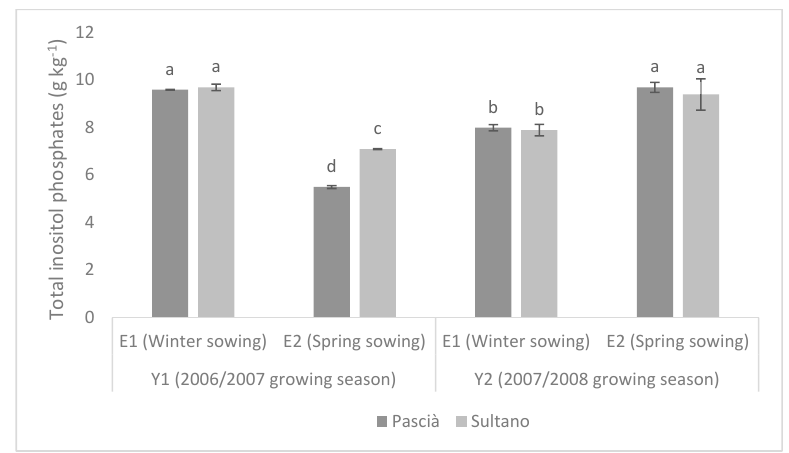
Figure 2. Content of Total inositol phosphates in seeds (g kg − 1 ± SE) of the two varieties in the two growing seasons. Means with different letters are significantly different (Fisher’s LSD, p ≤ 0.05). Planting season did not affect TI level for Pascià and Sultano in Y1 while it did it in Y2, when winter sowing resulted in significantly higher TI values than spring one (Figure 3).